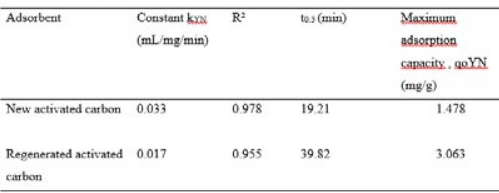
Linear plot of ln [Ct / (C0-Ct)] against treatment time (t) was used to determine the value of kYN based on the intercept and slope of the plot (Table 3). Based on the Yoon and Nelson model, the value of qoYN bare activated carbon and modified activated carbon are 1.478 mg/g and 3,063 mg/g.,